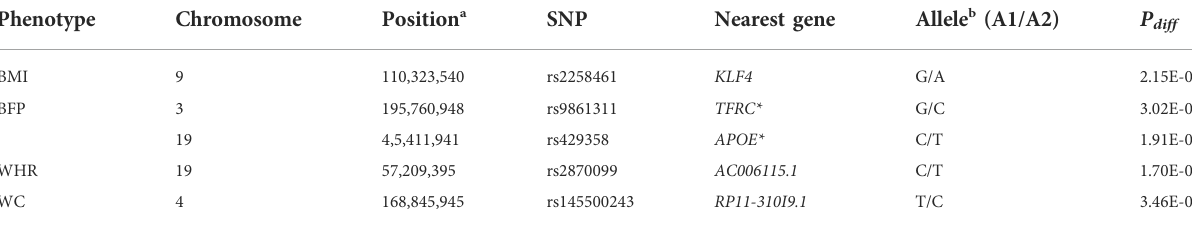
TABLE 2 The results of the age-strati fi ed analysis on obesity-related phenotypes ( P diff < 5 × 10 – 8